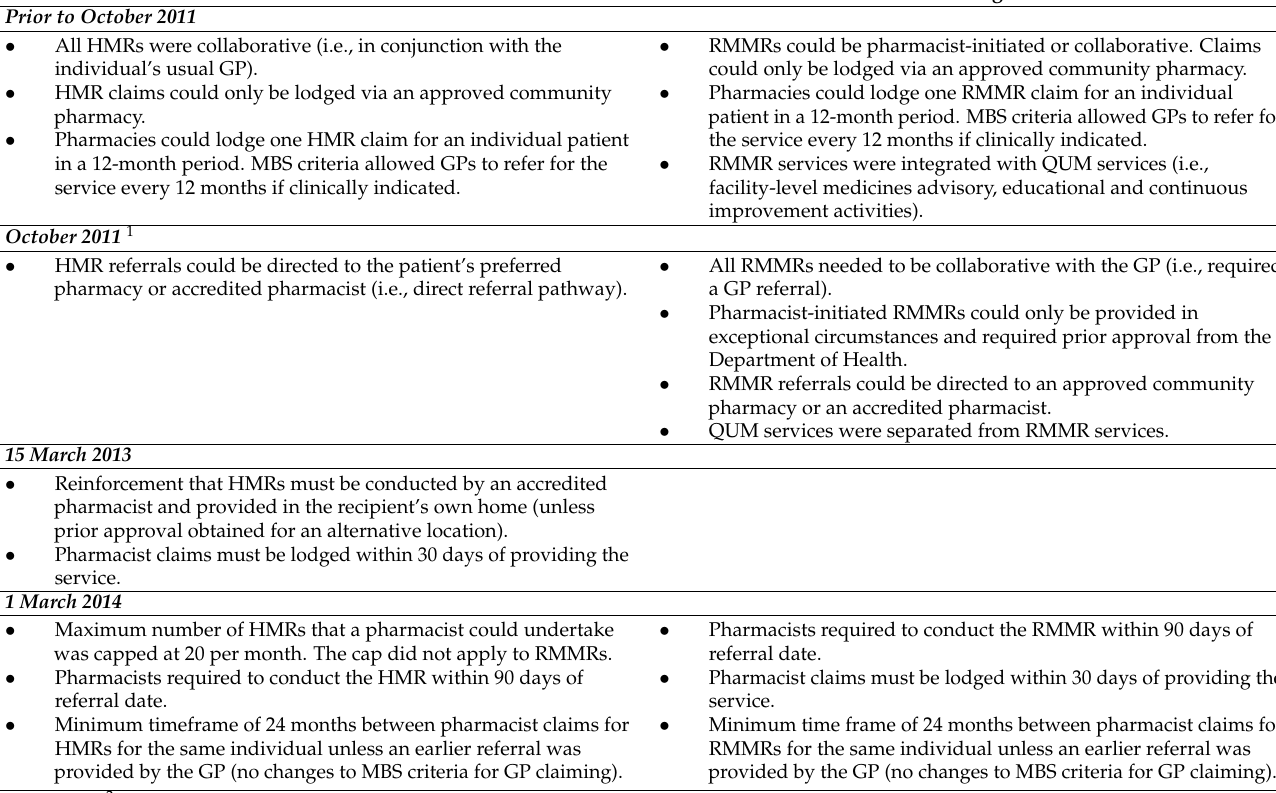
Table 1. Summary of changes to the HMR and RMMR programs during 2009 and 2019 [7,8]. Home Medicines Review